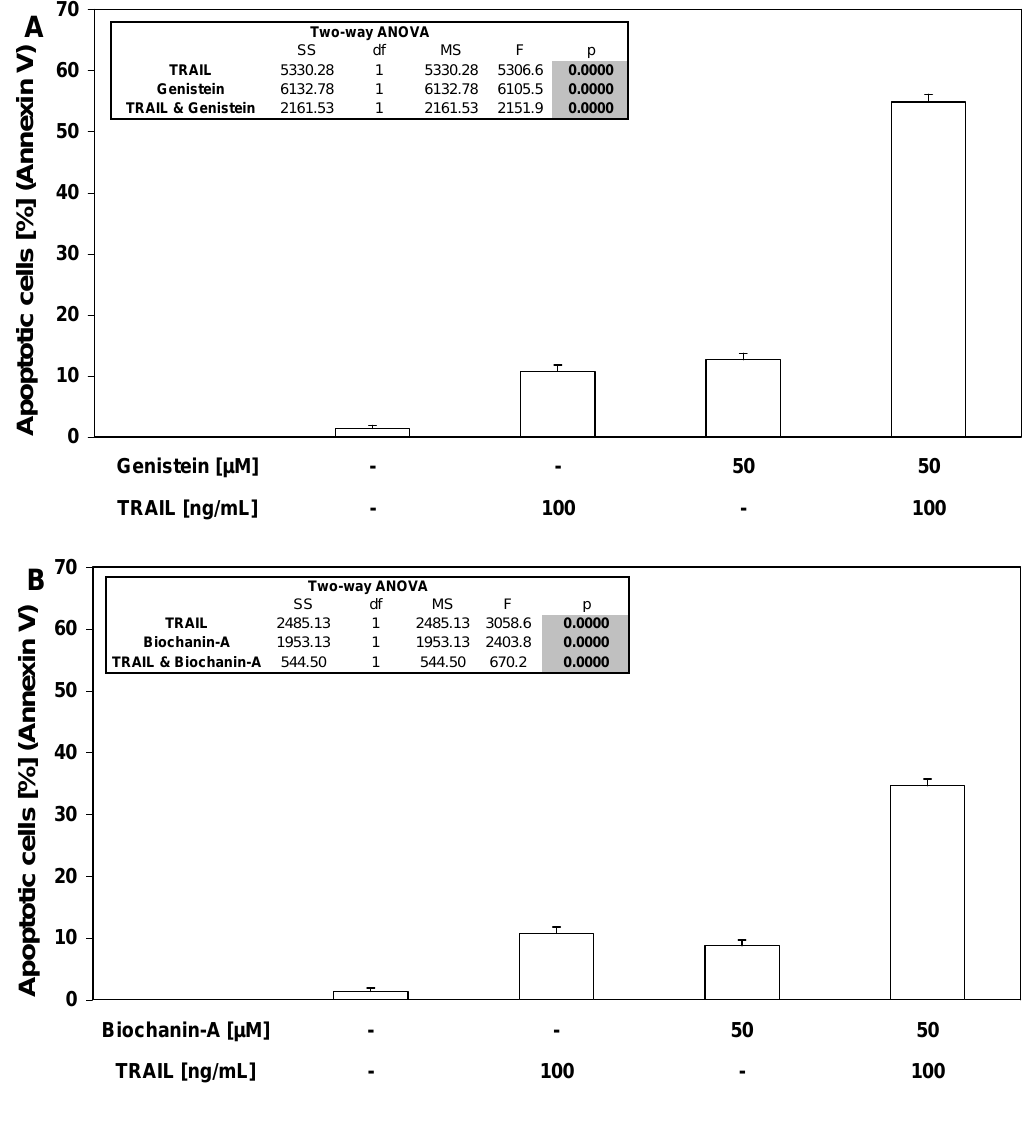
Figure 5. TRAIL induced apoptosis in combination with isoflavones in HeLa cancer cells. The cancer cells were incubated for 48 hours with TRAIL at the concentrations of 100 ng/mL and isoflavones: ( A ) genistein, ( B ) biochanin-A, ( C ) neobavaisoflavone at the concentration of 50 μ M, ( D ) comparison between isoflavones. Detection of apoptotic cell deaths by fluorescence microscopic using annexin V-FITC, Ethidium Homodimer III and Hoechst 33342 staining. The values represent mean ±SD of three independent experiments performed in quadruplicate (n = 12) (p <